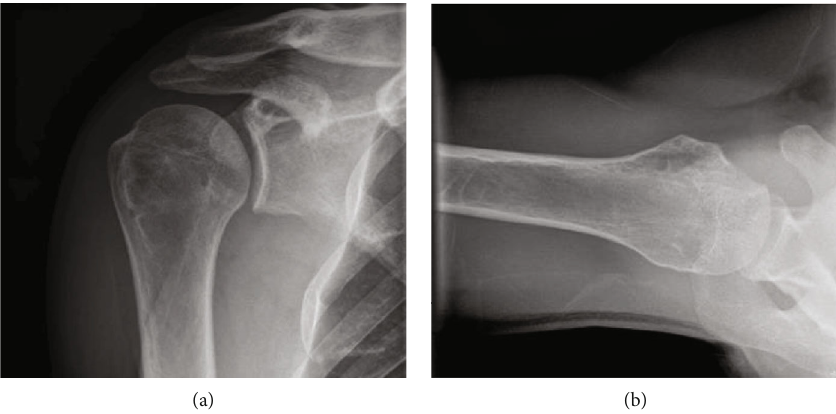
Figure 5: Postoperative AP (a) and (b) axillary views of the